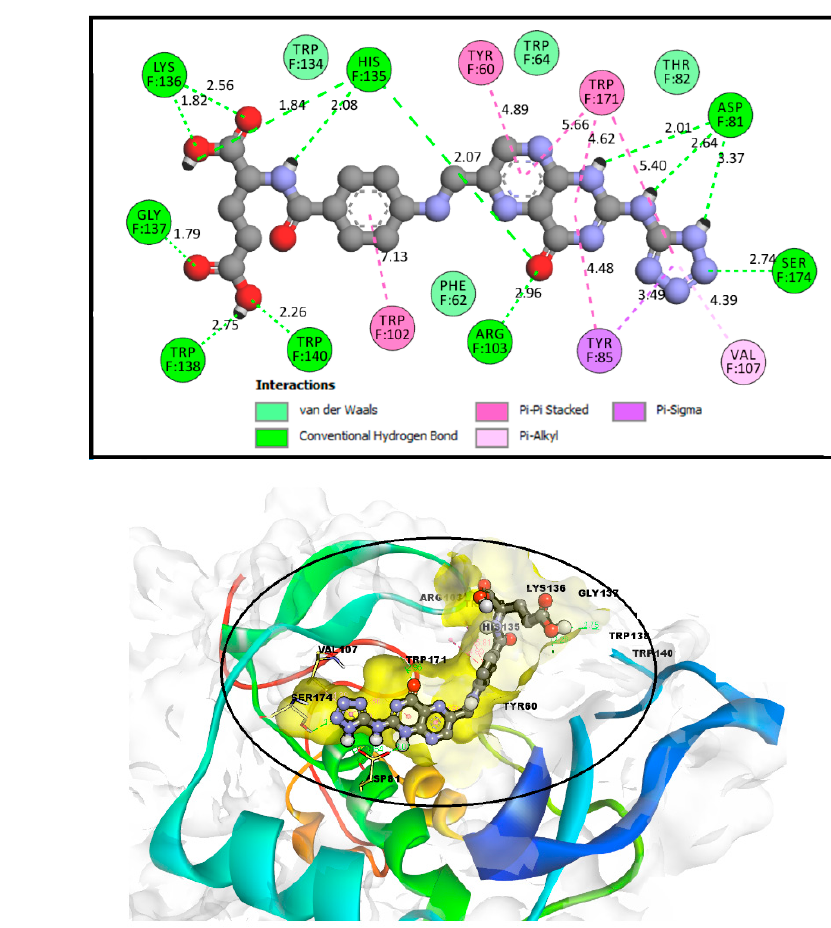
Figure 5. ( a ) Analysis of FOL03 (gray C, red O, and blue N) docked with FR α (PDB ID: 4LRH) presented as solid surface rendering. ( b ) The 2D binding site interaction between FOL03 and FR α .